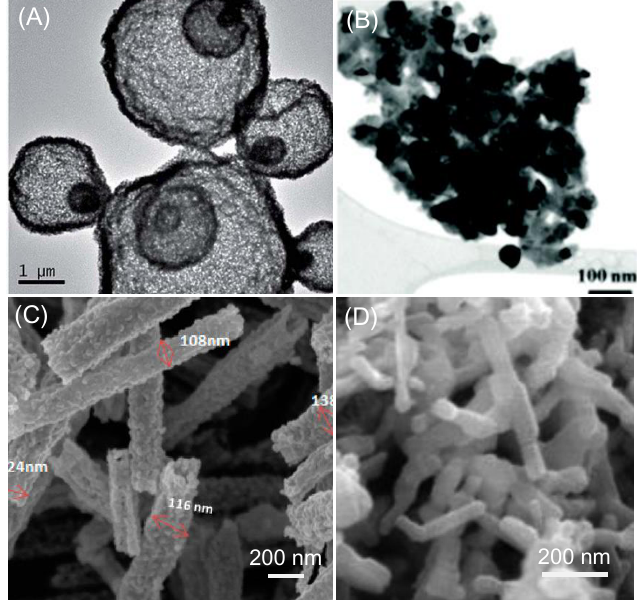
Figure 5. Examples of perovskite oxide electrocatalyst with a large surface area. ( A ) TEM image of multi-shelled La 0.9 Sr 0.1 CoO 3 with a high surface area (adapted from [79], with permission from Royal Society of Chemistry, 2015). ( B ) TEM image of La-doped Ba 0.5 Sr 0.5 Co 0.8 Fe 0.2 O 3−δ with an average diameter of ~50 nm (adapted from [80], with permission from RSC Publishing, 2015). ( C ) SEM image of a high surface area La(Co 0.71 Ni 0.25 ) 0.96 O 3−δ nanorod prepared by electrospinning (reproduced from [81], with permission from American Chemical Society, 2016). ( D ) SEM image of microporous La 0.8 Sr 0.2 MnO 3 nanorod synthesized with a self-assembly assisted method (reproduced from [85], with permission from Elsevier,